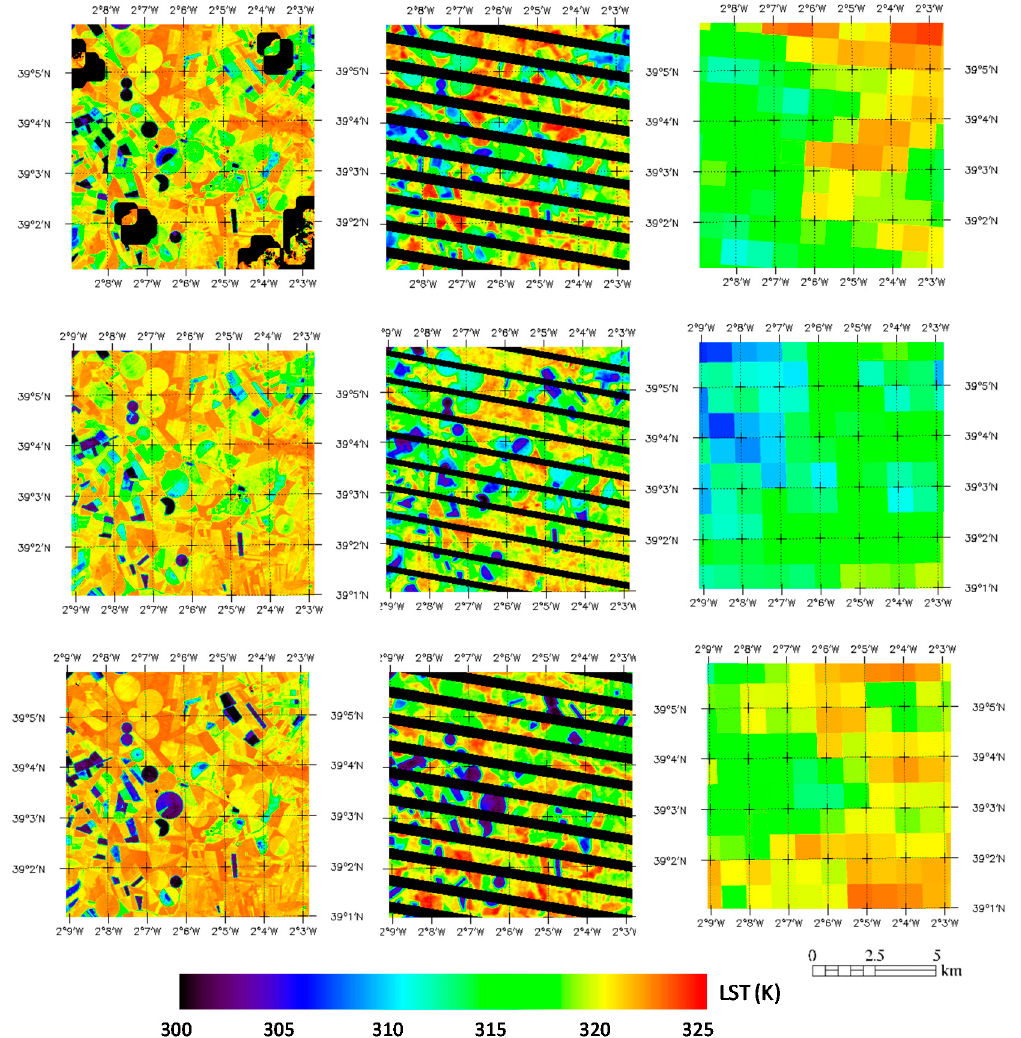
Figure 8. Disaggregated LST 10m (left column), LST derived from original 30 m L7-ETM+ Thermal InfraRed (TIR) band (center), and MOD11A1_LST product (right column). Examples corresponding to dates 9 July 2018 (up), 16 July 2018 (middle), and 25 July 2018 (bottom).